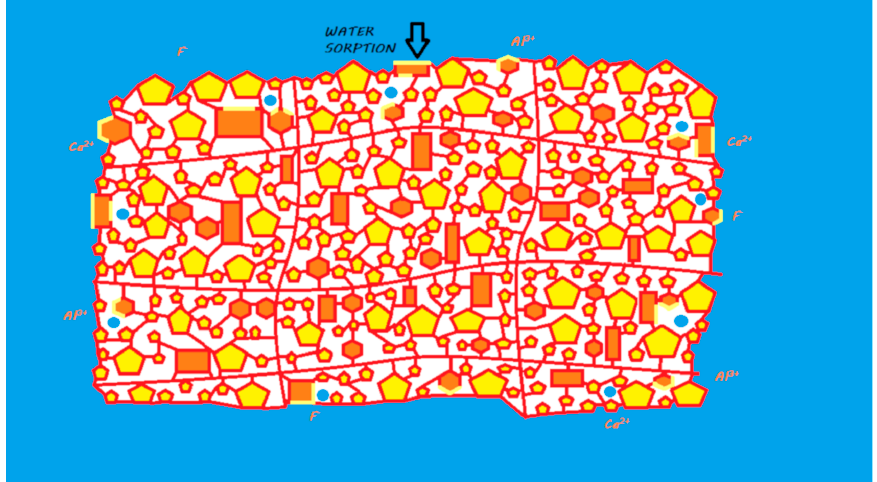
Figure 18. Diagram of ion release from Cention N once it is in contact with the oral environment.